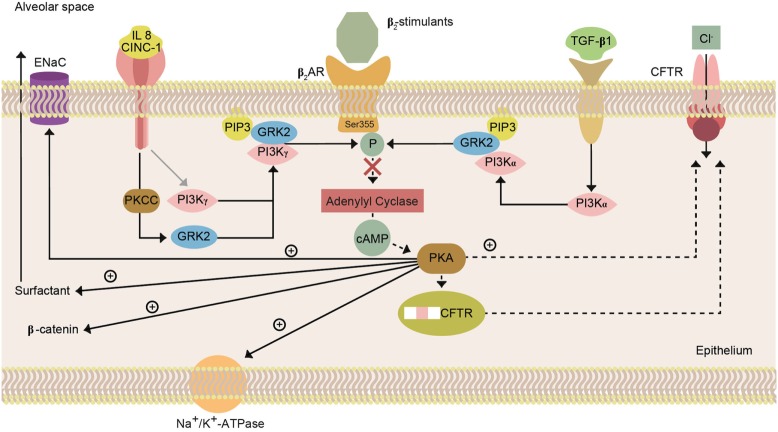
Rationale for the problematic role of β2 adrenergic agonists in clinical trials. Schematic representation of the mechanisms by which interleukin-8 (IL-8)/cytokine-induced neutrophil chemokine (CINC)-1 and transforming growth factor (TGF)-β1 have a synergistic inhibitory effect on the β2-adrenergic receptor (β2AR) signaling pathway in type II alveolar (ATII) cells. IL-8/CINC-1 and TGF-β1 cause the activation of different phosphoinositide 3-kinase (PI3K) isoforms. However, IL-8/CINC-1 but not TGF-β1 phosphorylates G-protein-coupled receptor kinase 2 (GRK2) via a protein kinase C-zeta (PKC-ζ)-dependent mechanism explaining why the blockade of IL-8/CINC-1 prevents the TGF- β1-mediated inhibition of the β2AR signaling pathway in ATII cells. This results in the translocation of the protein complex GRK2 and PI3K to the cell membrane. This protein complex causes phosphorylation at the Ser355 heterologous desensitization and downregulation of the β2AR in ATII cells. IL-8/CINC-1 and TGF-β1 then prevent the activation of 3′-5′-cyclic adenosine monophosphate (cAMP)/protein kinase A (PKA) pathway that upregulates the vectorial fluid transport across the alveolar epithelium via phosphorylation and increased expression of cystic fibrosis transmembrane conductance regulator (CFTR) at the plasma membrane of ATII cells. The solid lines indicate the pathways stimulated by IL-8/CINC-1 and the dashed lines indicate the pathways inhibited by these mediators (416).